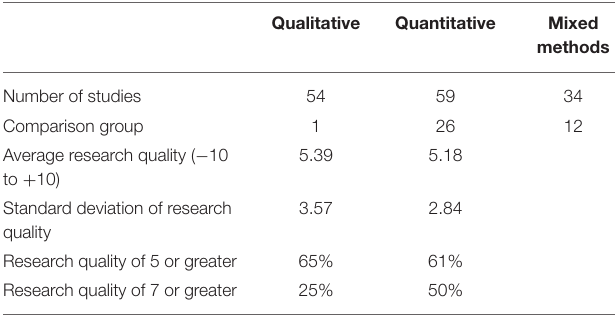
TABLE 4 | Research quality by study design. TABLE 5 | Average research quality by study design and outdoor learning